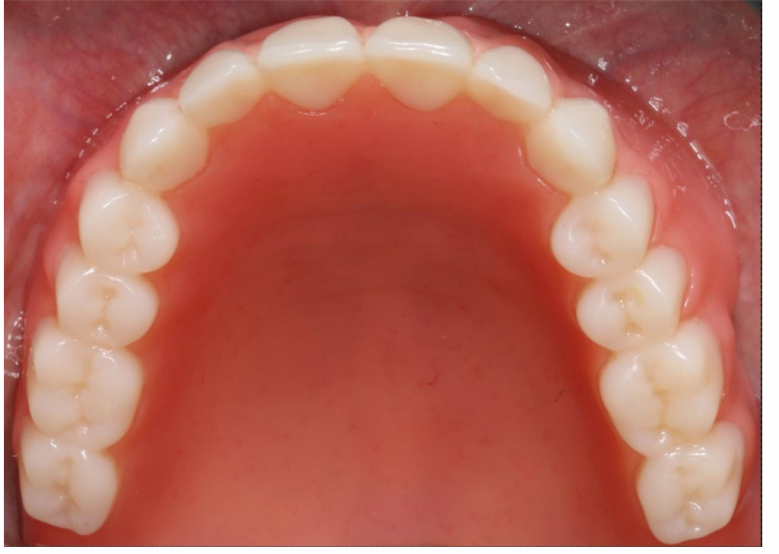
Figure 20. Inserted complete denture in the upper